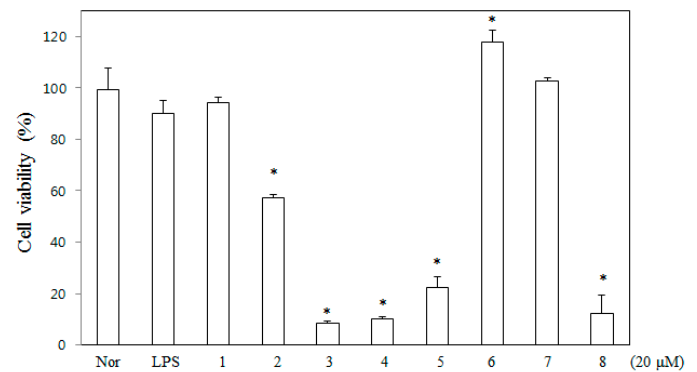
Figure 2. Effects of eight flavanones on the viability of RAW 264.7 cells. Cells grown in